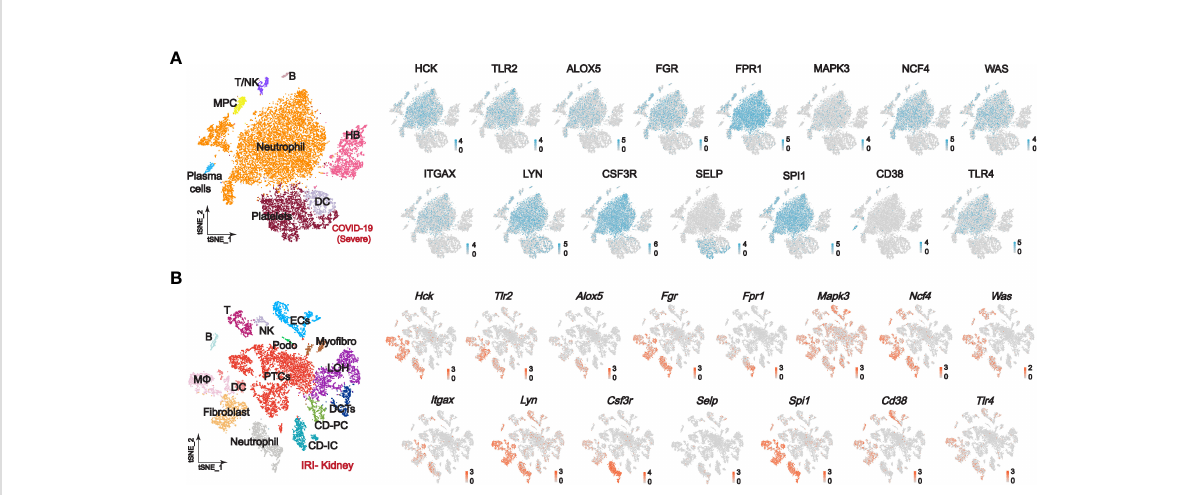
FIGURE 5 Single-cell sequencing explores the expression of PPI-hub genes in immune and kidney cells. (A) In the peripheral blood of patients with severe COVID-19, the PPI-hub genes were predominantly expressed in neutrophils, macrophages, and dendritic cells. (B) In renal parenchymal cells of IRI-AKI mice, PPI-hub genes were mainly expressed in proximal tubular cells, podocytes, and endothelial cells. In IRI-AKI renal immune cells, PPI-hub genes were mainly expressed in neutrophils, macrophages, and dendritic